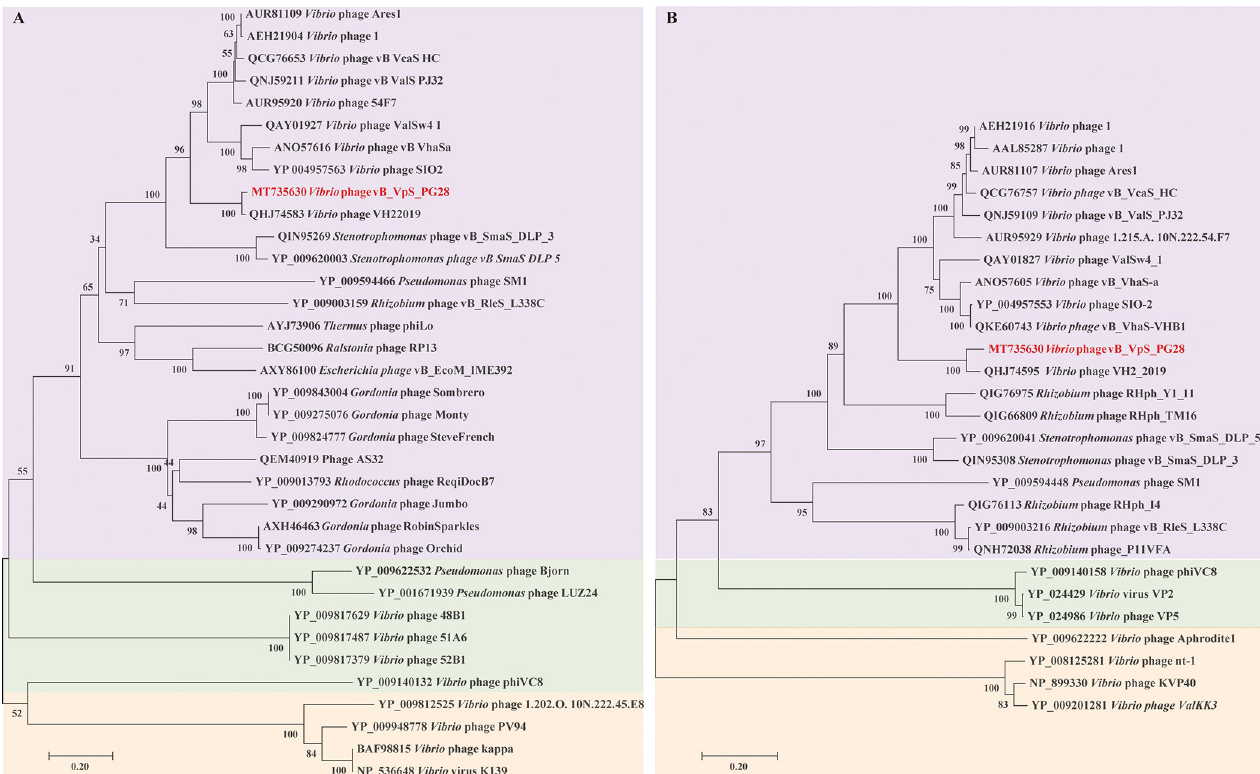
Fig 6. Phylogenetic relationship between selected phage amino acid sequences. (A) Tree assembled with terminase large subunit sequences. (B) Tree assembled with DNA polymerase sequences. The phages of family Siphoviridae are shown in purple. The phages which belonged to family Podoviridae and Myoviridae are selected as outgroups and shown in green and yellow, respectively. The Vibrio phage vB_VpS_PG28 is marked in red.